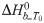
Simulations of expected Tm changes as a function of ligand binding enthalpy (ΔHb_T00) and association constant (Kb).(A) Simulated titration curves for Kb = 109 M-1 with enthalpy values varied from -120 to 120 kJ mol-1. (C) Simulated titration curves for Kb = 105 M-1 with enthalpy values varied from -120 to 120 kJ mol-1. (B) Tm shifts as a function of enthalpy ([POT1] = 5 μM; [Lt] = 50 μM). (C) The same Tm shift can arise from many combinations of Kb and ΔHb_T00. These simulations used: ΔHU_Tr0 = 44200 J/mol, ΔCp_U = 15000 J/mol-K, ΔSU_Tr0 = 1361.5 J/mol-K, Tm = 51.5°C, ΔCp_b = -500 J/mol-K and [POT1] = 5 μM. Other parameters were varied as indicated.